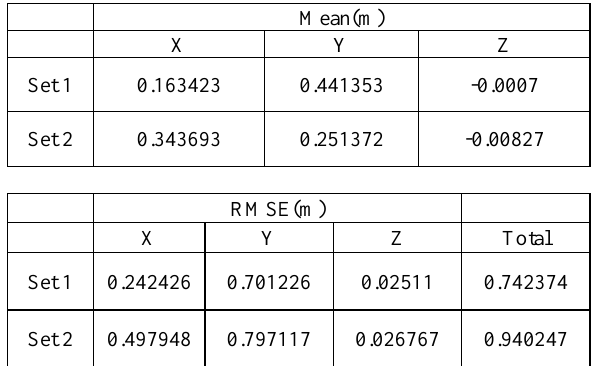
Table 4. Mean & RMSE using reference